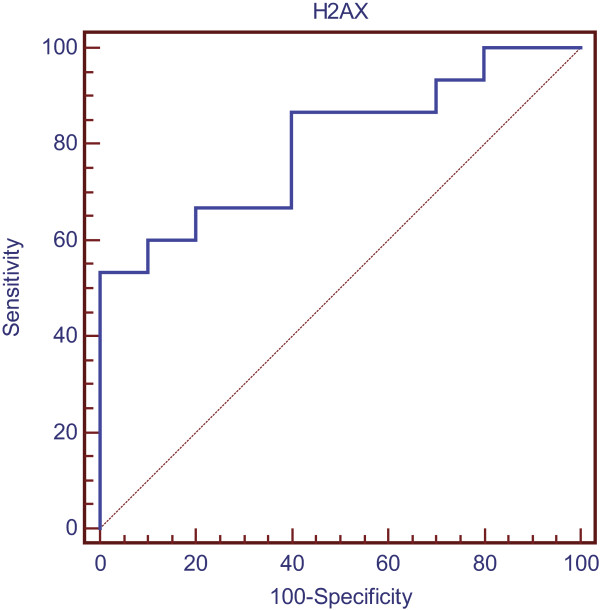
ROC curve of residual γ-H2AX fluorescence 24 h post-irradiation for determining the grades of OM. Receiver Operating Characteristic (ROC) analysis was performed by SPSS software and cutoff value was determined based on Youden index. The ordinate represents the true positive rate, the abscissa represents the false positive rate. The area under the curve (AUC) was used to assess the predictive value of γ-H2AX.